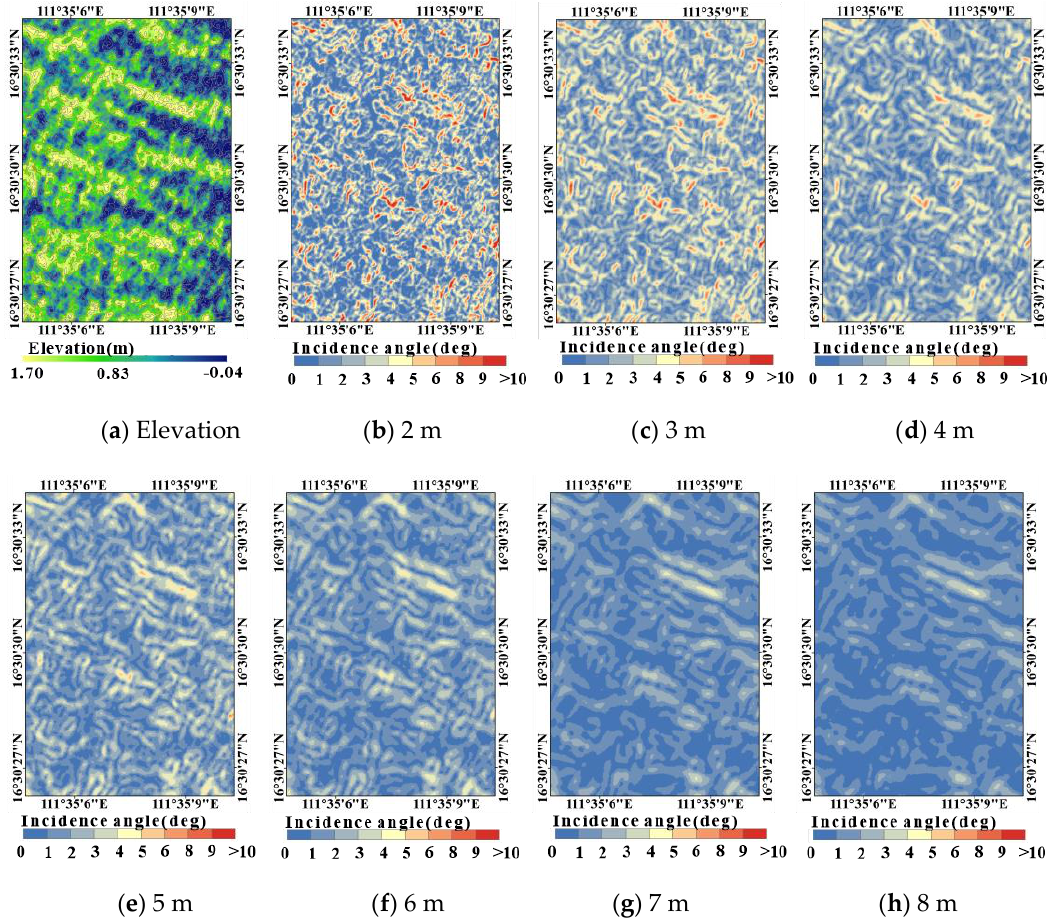
Figure 6. Incidence angle distribution on the ocean surface undulations (( a ). Point cloud of the water surface, ( b – h ). Incidence angle distribution with different estimation radii.).